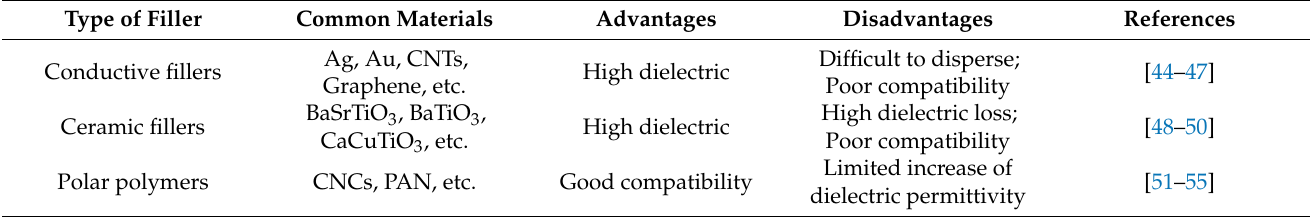
Table 2. Common high dielectric fillers and their advantages and